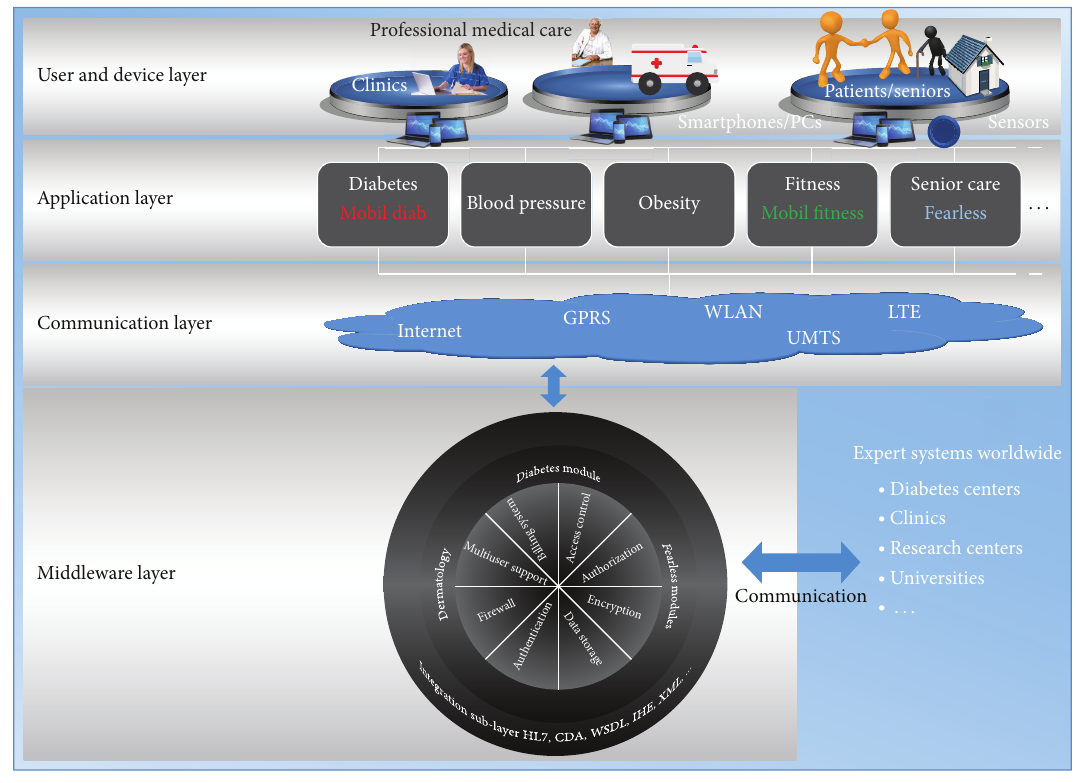
Figure 5: Architecture of the telemedical